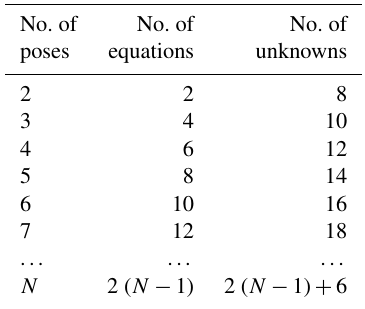
Table 1. Number of equations and number of unknowns of the pla- nar 3R serial chain. No.